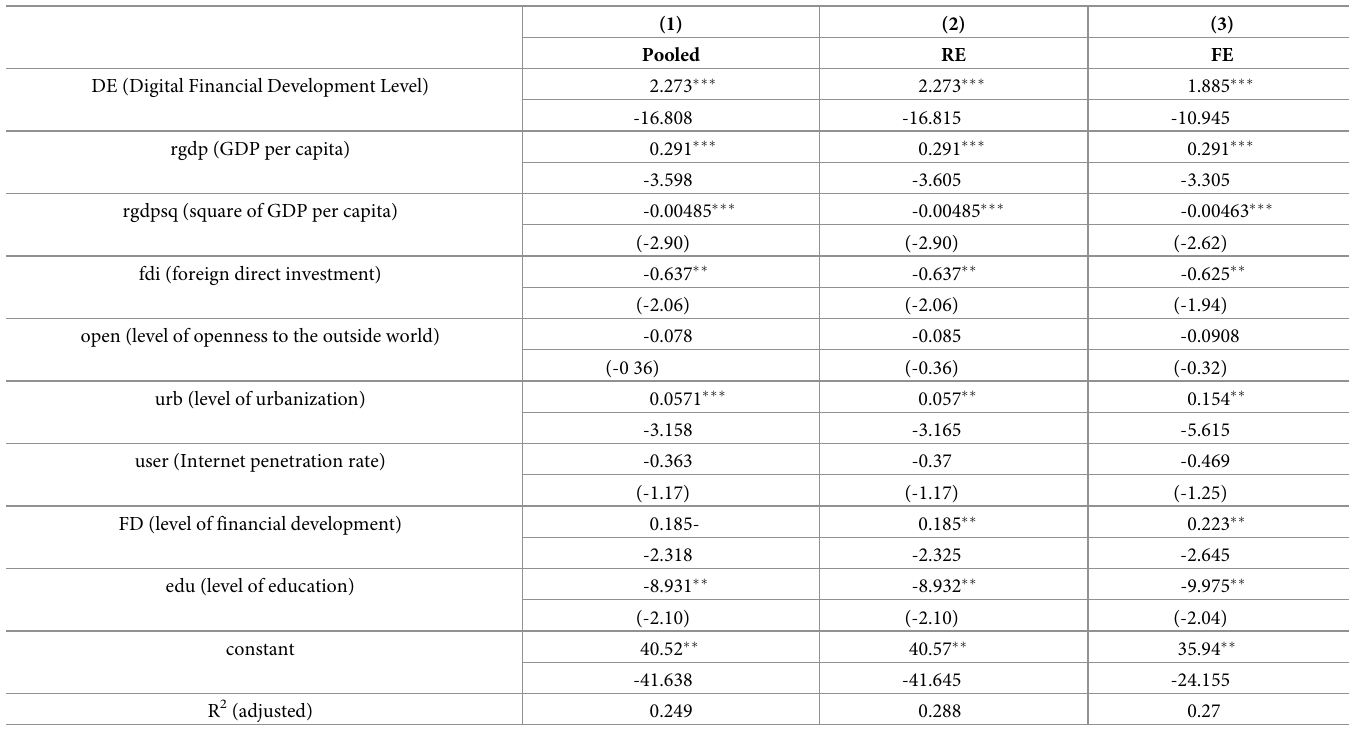
Table 2. Estimation results of the basic